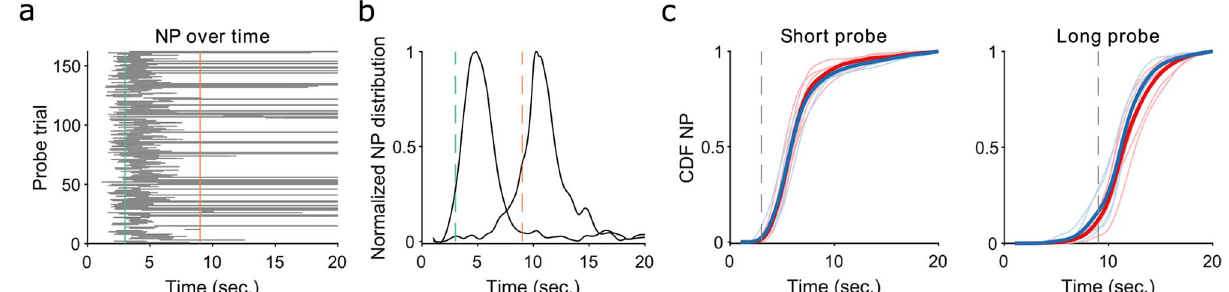
Figure 4. Preserved Interval timing in TAAR5-KO mice. ( a ). Example distribution of NP during short probe trials. Each row is a probe, the solid grey line identifies the interval in which the animal was poking into the short hopper location. Green and orange vertical lines identify the short and long time, respectively. ( b ). Normalised NP distribution for short and long probe trials for the example subject in a. Green and orange vertical dashed lines identify the short and long time, respectively. ( c ). Cumulative distribution of NP activity for each subject and each group. Solid lines identify group average. Each single lighter line is a subject. Blue curves are for WT mice, while red curves for TAAR5-KO, as